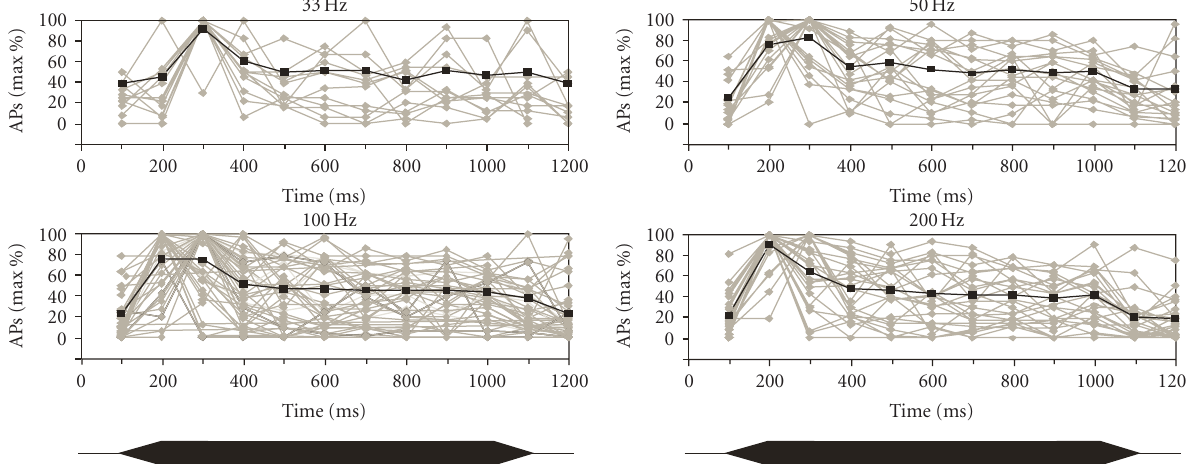
Figure 3: Temporal patterns of the responses to constant-amplitude sine wave stimuli. For this graph, spike activity of each unit was normalized to the greatest number of spikes elicited during a 100 ms time bin at any of the four frequencies presented. The envelope of the stimulus trace is shown at the bottom. Peak-peak displacement was 160 μ